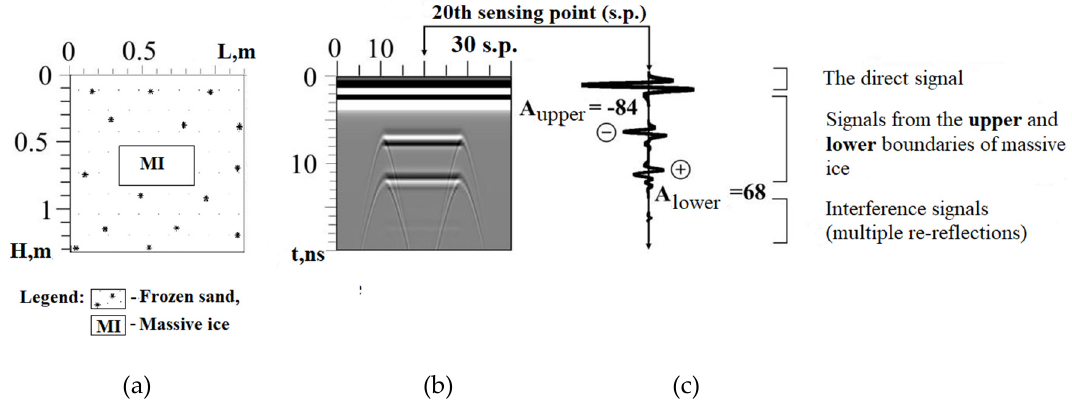
Figure 5. The GPR model of massive ice h = 0.29 m for AB-1200: ( a ) model of frozen rock mass (FR) with the inclusion of massive ice (MI); ( b ) radargram; ( c ) GPR trace.